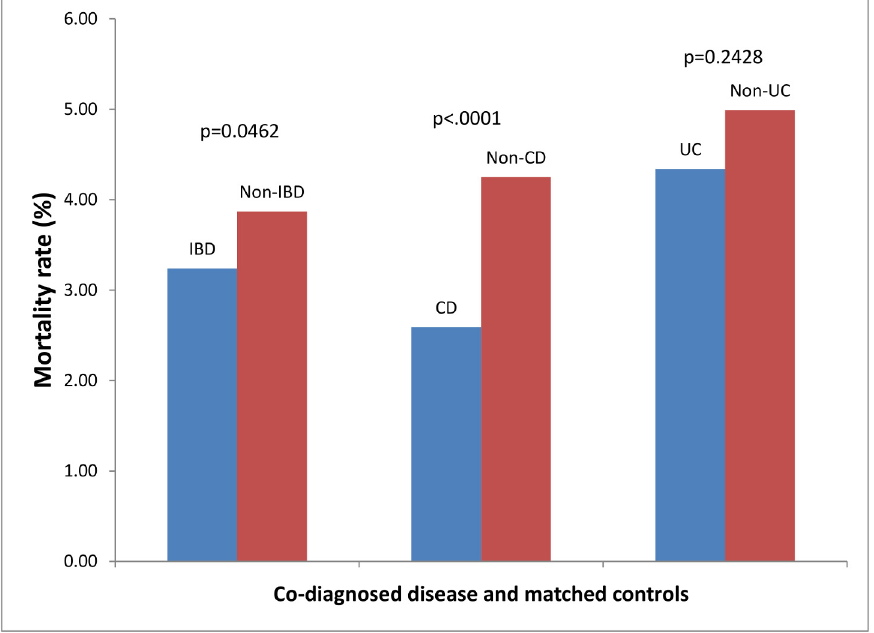
Fig 3. Hospital Mortality Rates for Co-Diagnosis and Matched Controls for Patients Hospitalized with Primary Diagnosis of